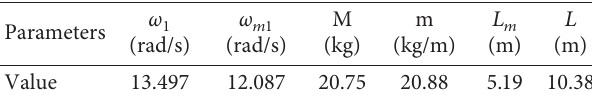
Table 5: Comparison results of cable forces. Method Force (kN) Relative deviation (%) Pressure sensor method 935.00 — Conventional method 1612.39 72.45 974.59